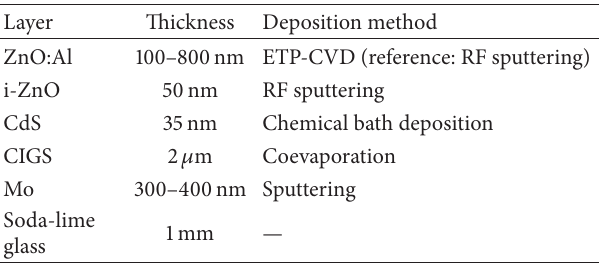
Table2:StructureofCIGSsolarcell,withthedepositionprocedures and film thicknesses included for each